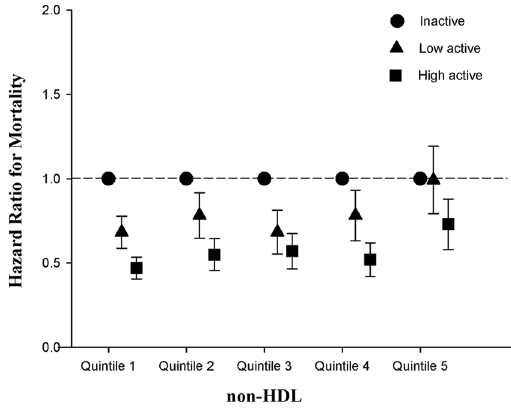
Figure 2. Adjusted hazard ratios for mortality based on the quintiles of non-high-density lipoprotein cholesterol and physical activity status among older individuals.